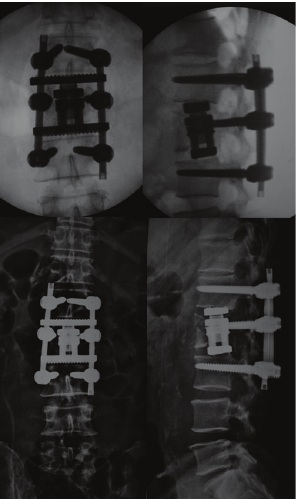
Figure 2: Intraoperative fluoroscopy and immediate postoperative X-ray showing implant position and fracture reduction.